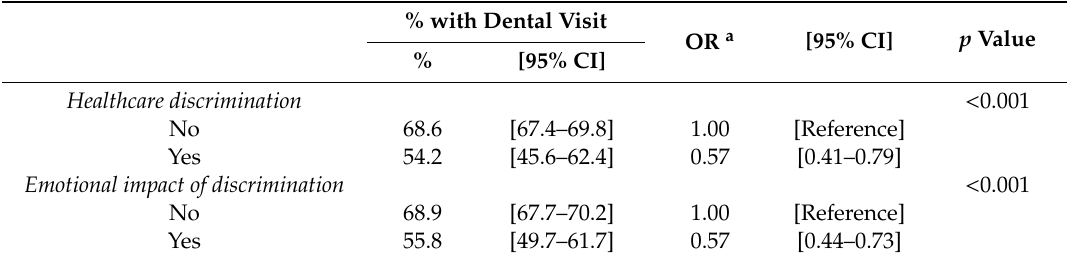
Table 2. Crude associations between each indicator of racial discrimination and use of dental services in the past year among American adults ( n = 11,950).